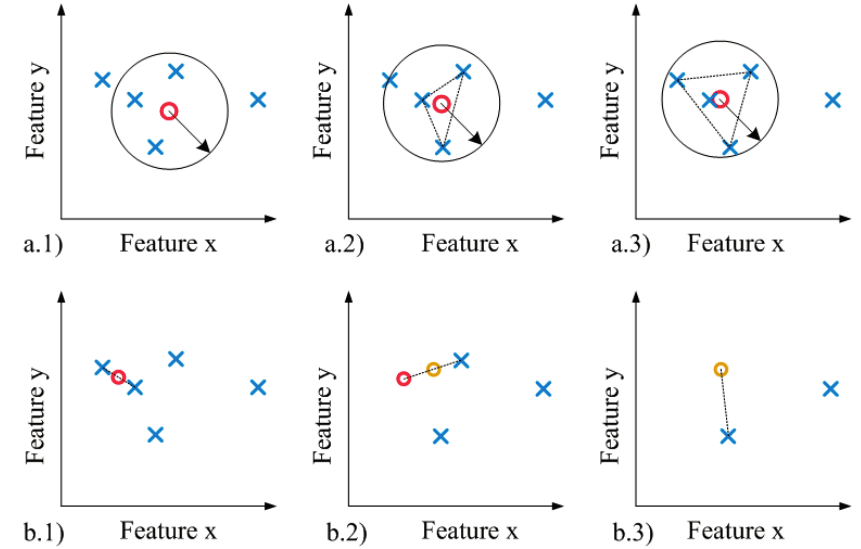
Figure 4. ( a ) Centroid-based method; ( b ) Distance-based